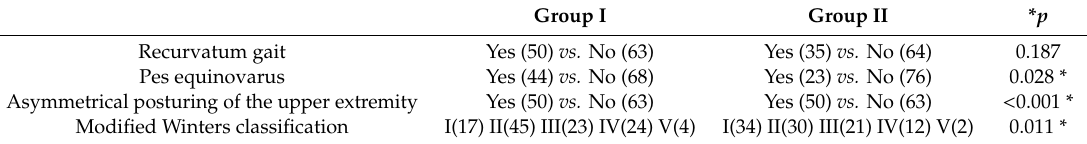
Table 2. Comparisons of observational gait parameters between the groups.